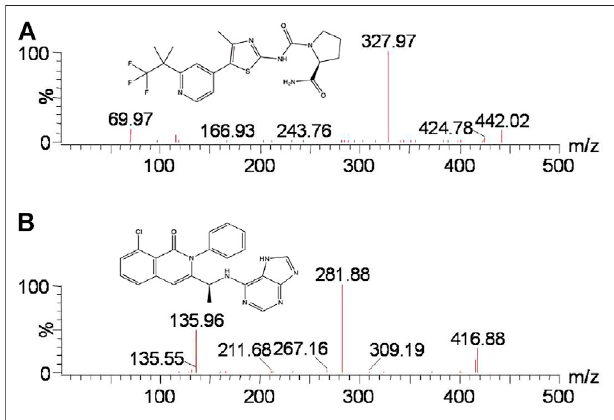
FIGURE 1 | Mass spectra of alpelisib (A) and duvelisib ( IS, B ) in this study.